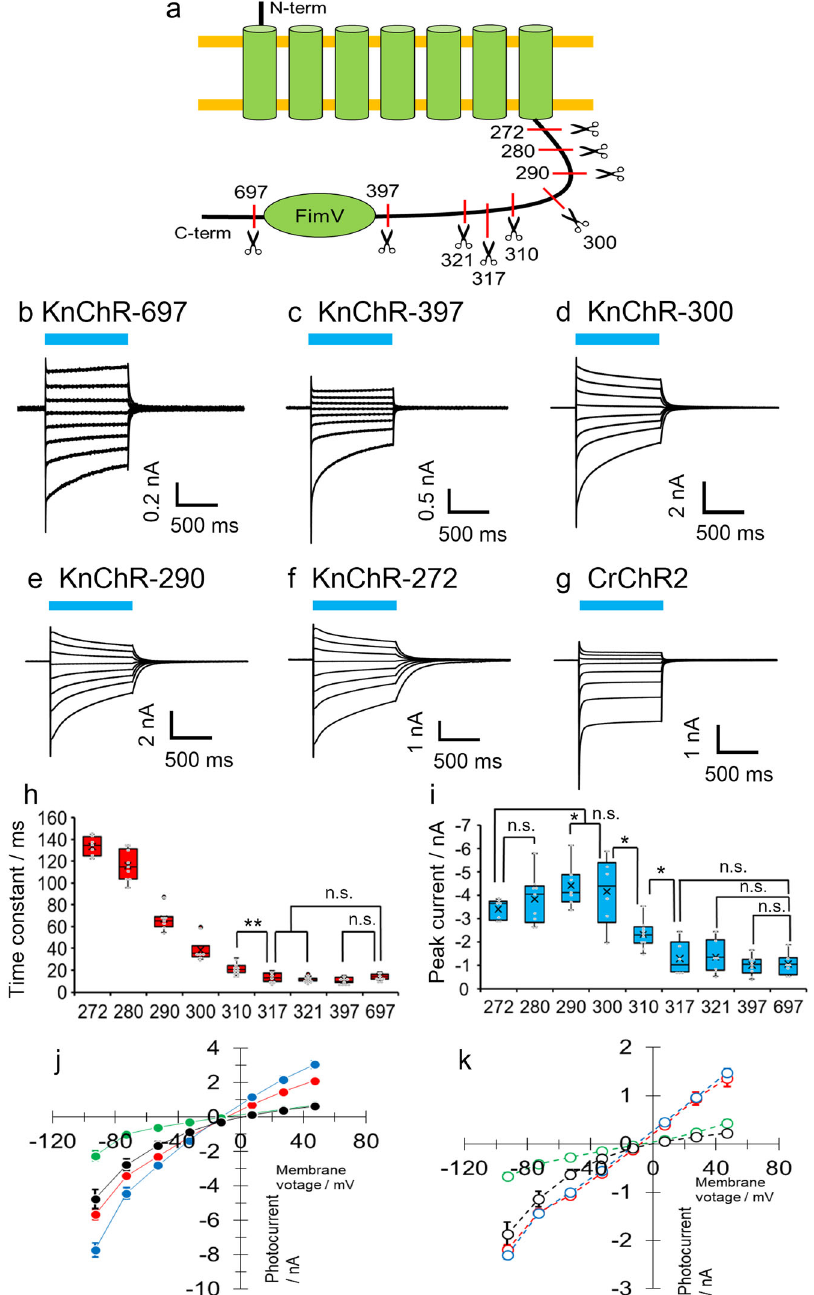
Fig. 2 Electrophysiological measurements of various C-terminal length constructs of KnChR. a Schematic drawing of truncated constructs. Amino acid positions truncated are indicated. b – g Photocurrent traces of various C-terminal length constructs and CrChR2. Blue bars indicate light application (480 nm, 12.3 mW/mm 2 ). Membrane voltage was clamped from at − 90 to + 50 mV by 20 mV steps. Standard solutions were used (See “ Methods ” ). h and i Comparison of time constants and photocurrent amplitude from KnChR variants. The membrane voltage was clamped at − 70 mV. N = 7 (272), 9 (280), 7 (290), 6 (300), 10 (310), 6 (317), 6 (321), 9 (397), and 7 (697). The box-and-whisker plot represents the median (center line), the mean (x), interquartile range (box limits) and 1.5 × interquartile range (whiskers). j , k I-V relationship of KnChR and CrChR2. Filled and empty symbols indicate peak and steady-state current, respectively. Red: KnChR-272 ( N = 7), Blue: KnChR-290 ( N = 7), Green: KnChR-397 ( N = 9), Black: CrChR2 ( N = 6). Data were presented as the mean ±